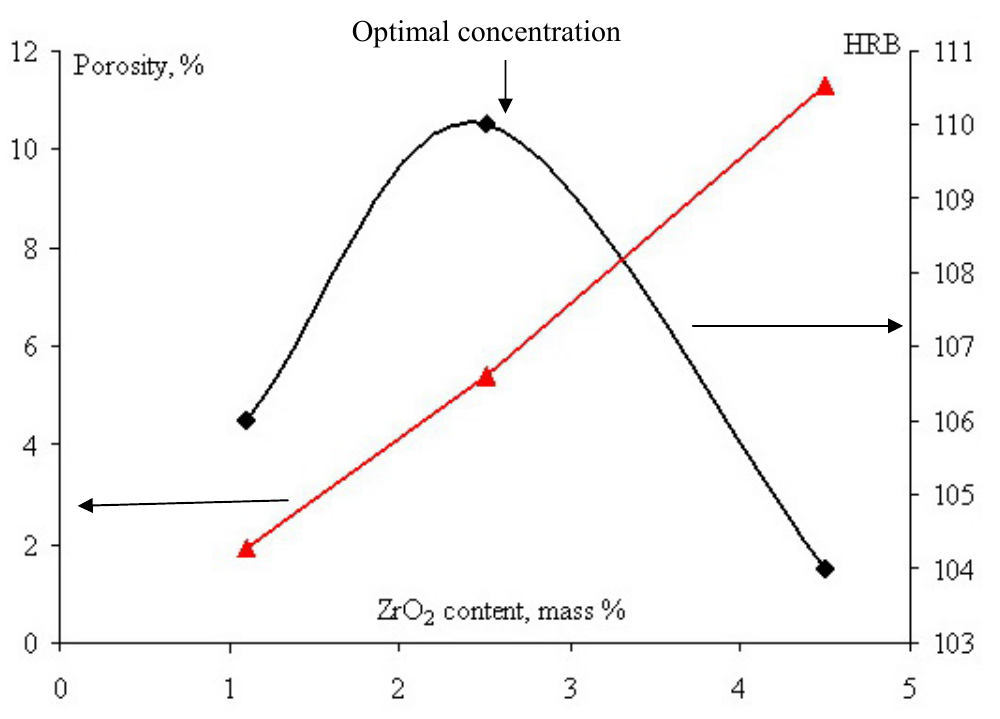
Figure 5. Porosity and HRB hardness as a function of the ZrO 2nano content of sintered